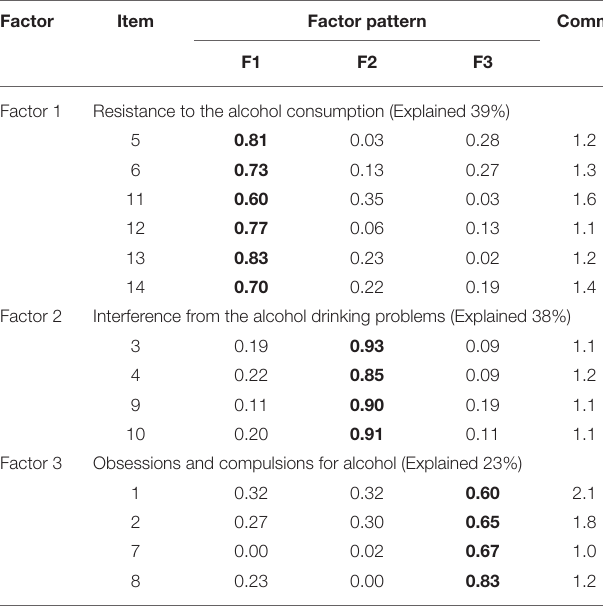
TABLE 4 | Concurrent validities of OCDS and its factors with other scales. OCDS scores OCDS ADS AUDIT